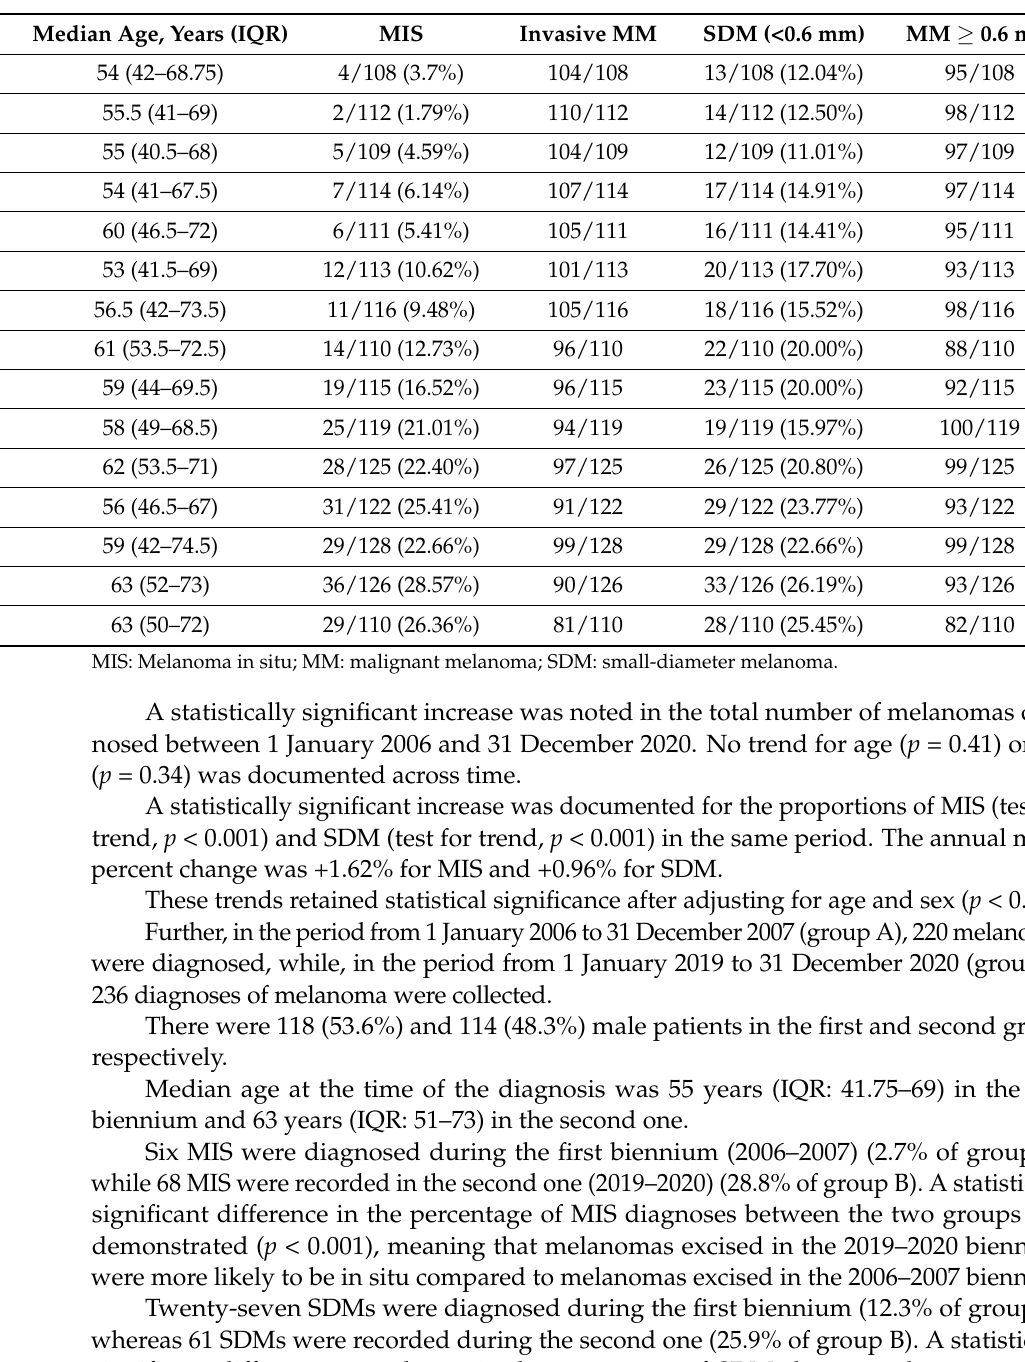
Table 1. Characteristics of cutaneous melanomas excised from 1 January 2006 to 31 December 2020 at the Dermatology Unit of Fondazione IRCCS Ca’ Granda Ospedale Maggiore Policlinico, Milan,